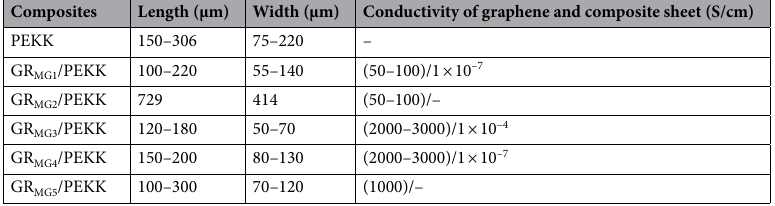
Table 1. The size and conductivity of PEKK and graphene/PEKK composite powder